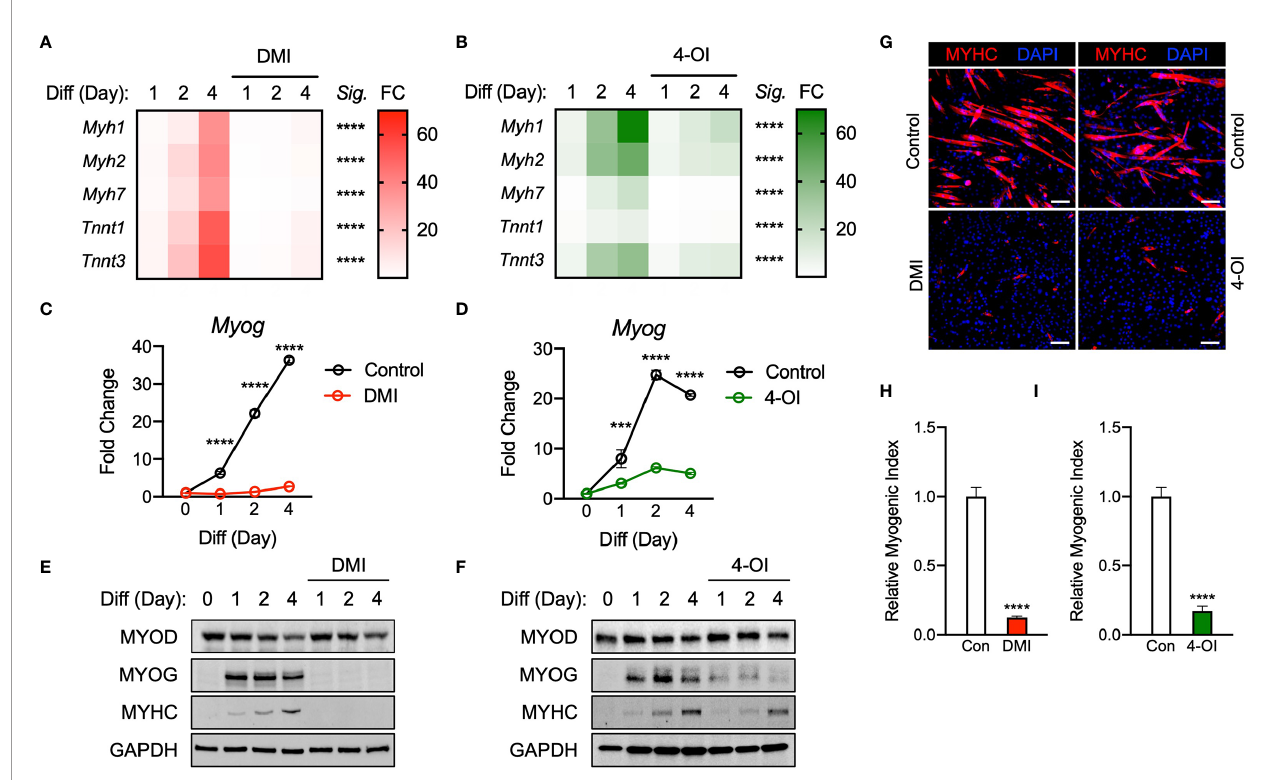
FIGURE 1 | Itaconate derivatives repress C2C12 myogenesis by modulating myogenic transcription mechanisms. Heatmap depiction of average fold change ( Sig. denotes statistical differences at day 4, n = 3) in myogenic gene transcription levels detected via RT-qPCR when exposed to differential media with or without (A) dimethyl itaconate (DMI: 125 µM) and (B) 4-octyl itaconate (4-OI: 125 µM) relative to the untreated group over a 4-day time course. Fold change of Myog mRNA expression at various time points comparing differentiation media (DM) control groups to (C) DMI and (D) 4-OI groups relative to expression without either treatment (n = 3). Western blotting data showing differences in myogenic transcription factor expression between DM treated groups and groups treated with DM plus (E) DMI and (F) 4-OI over a 4 day time course as well as groups which were not exposed to either treatment for any period. (G) MYHC staining at day 4 of differentiation. Bar: 100 m m. Relative myogenic index (percentage of total nuclei associated with myotubes) of (H) DMI and (I) 4-OI. *** denotes p <0.001, **** p <0.0001 compared to control based on